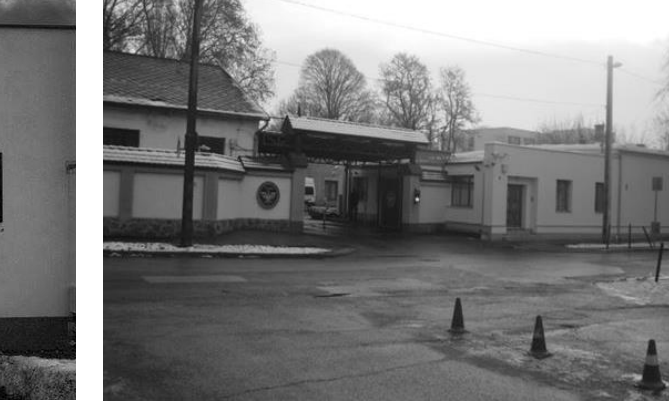
Fig. 9. Szombathely, Savaria Bootcamp Centre Fig. 10. Budapest, MH 1. Logistic Support Brigade